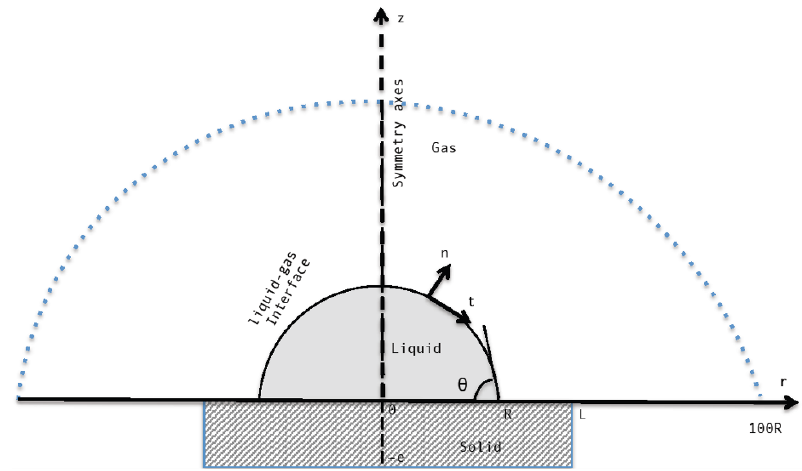
Figure 2. Physical Figure 2. Physical domain.